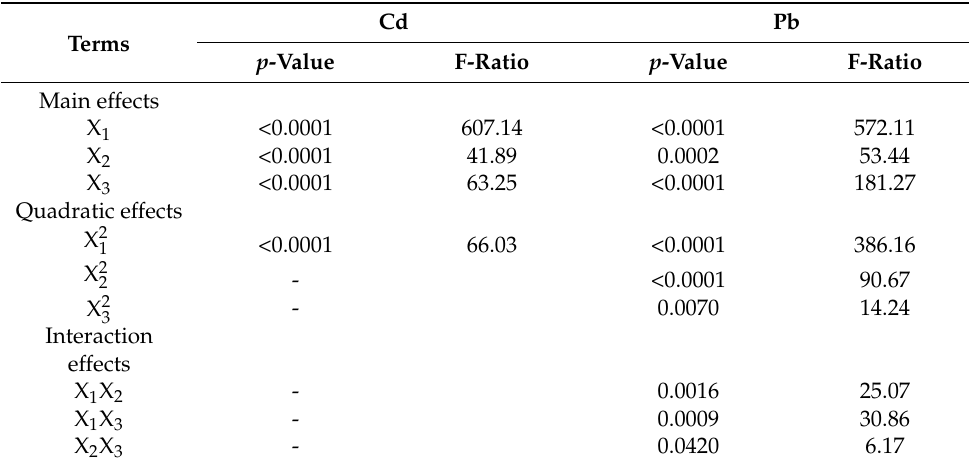
Table 4. p -Value and F-ratio of HPAE variables in final reduced